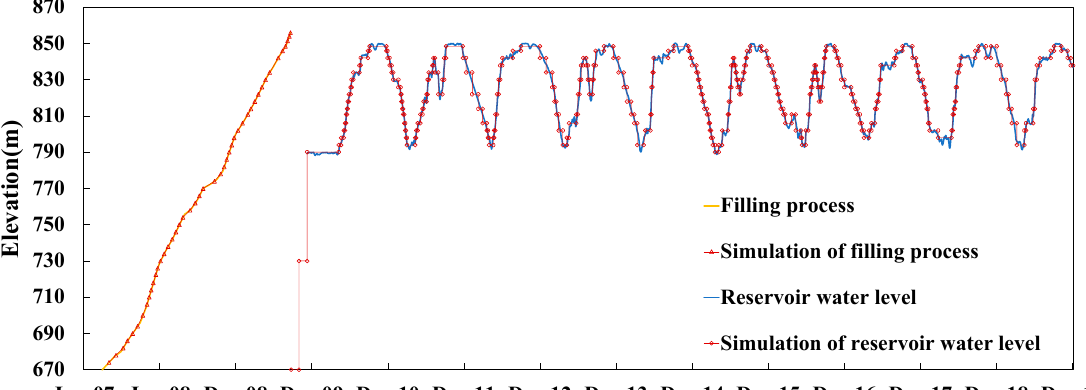
Figure 2. The dam filling process and the water level of the reservoir.